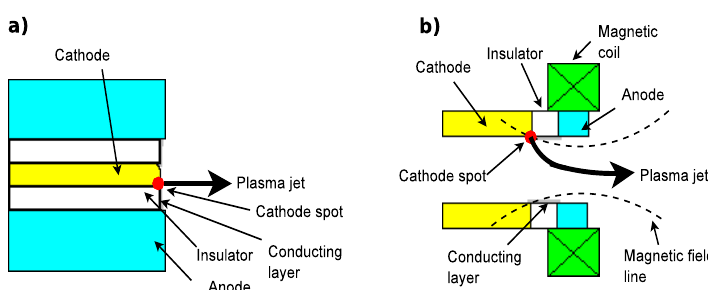
Figure 1. A cross sectional schematic of the coaxial-VAT ( a ) and ring-VAT ( b ). The direction of plasma ejection from the cathode spot is indicated.